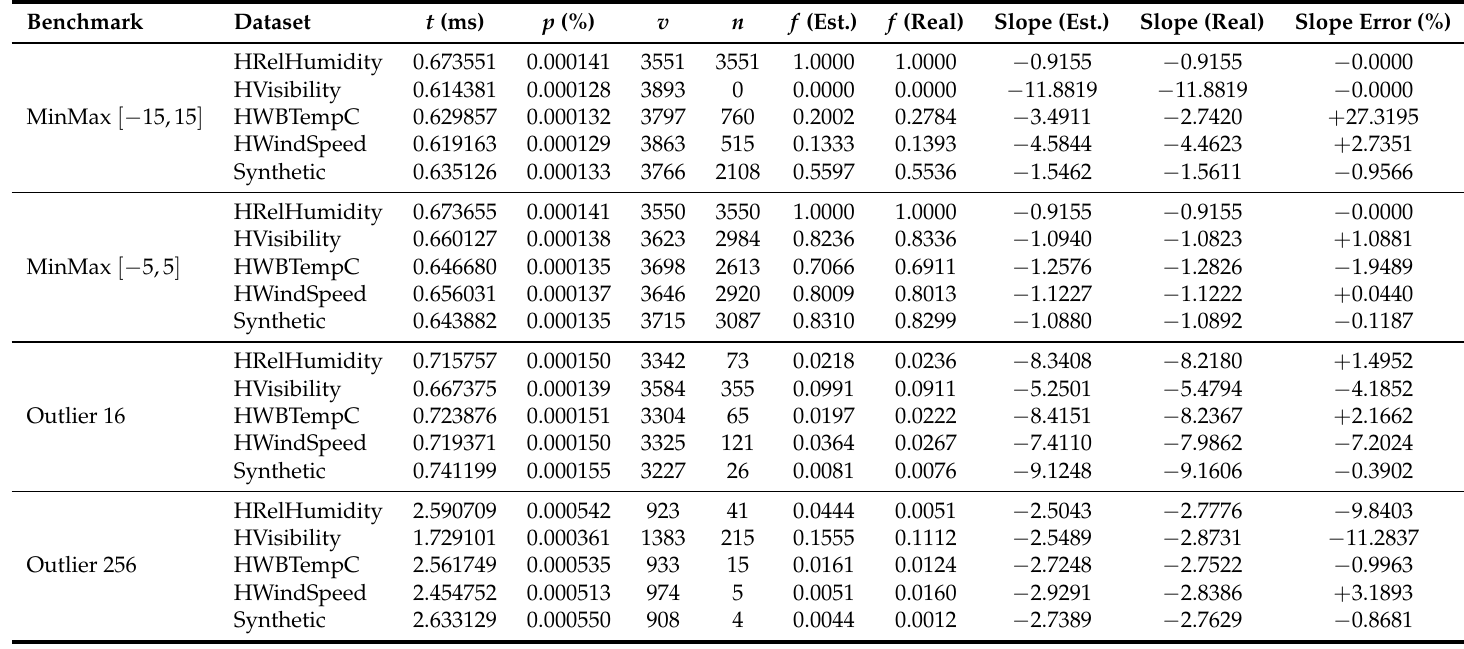
Table A2. Execution time results in fog-prone